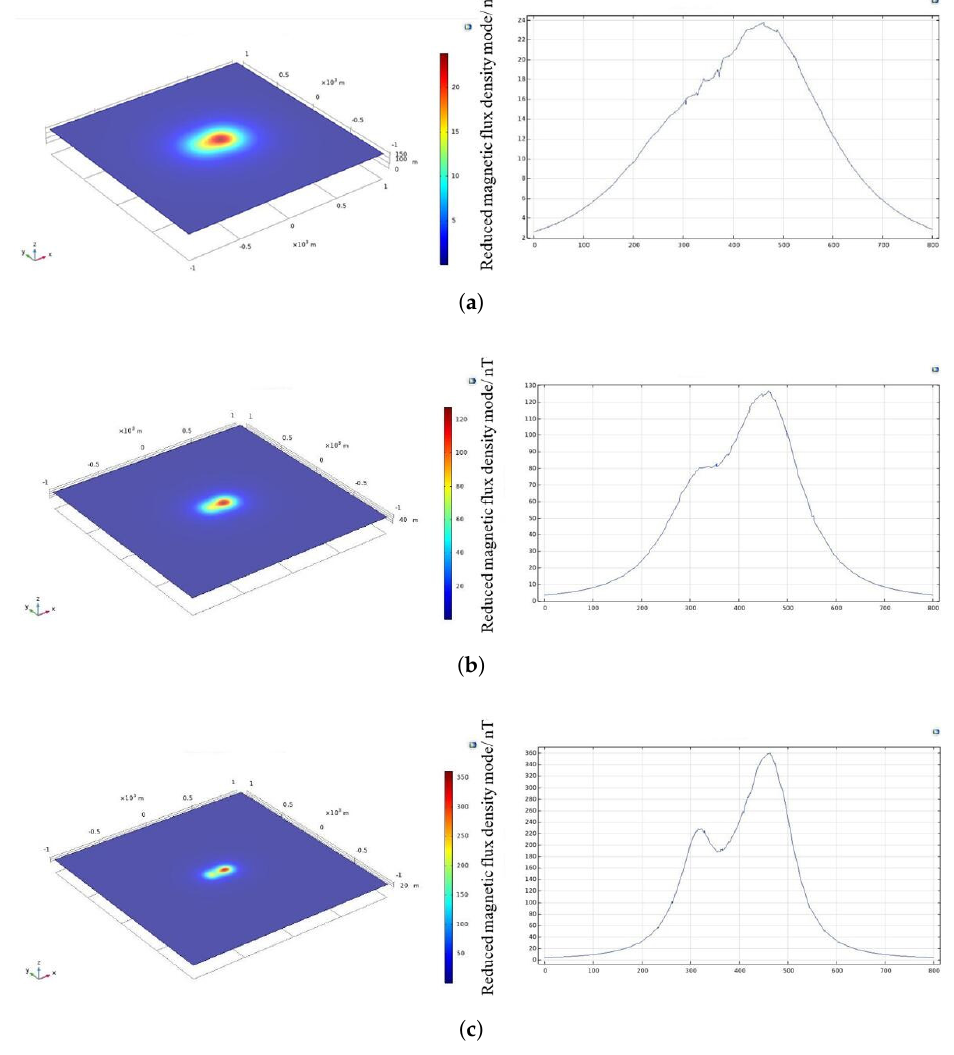
Figure 9. Schematic diagram of the spatial distribution of the submarine magnetic induction field. ( a ) The spatial scale is 1; ( b ) The spatial scale is 0.5; ( c ) The spatial scale is